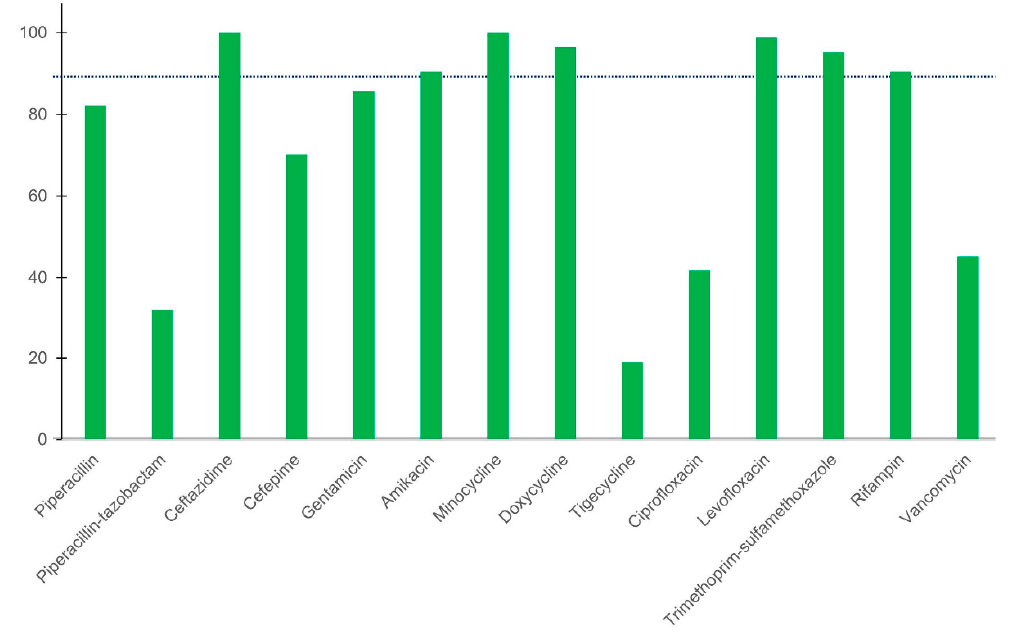
Figure 1. Categorical agreement between the disk diffusion and agar dilution methods for the antimicrobial susceptibility testing of E. anophelis . The broken line indicates an agreement rate of 90%.